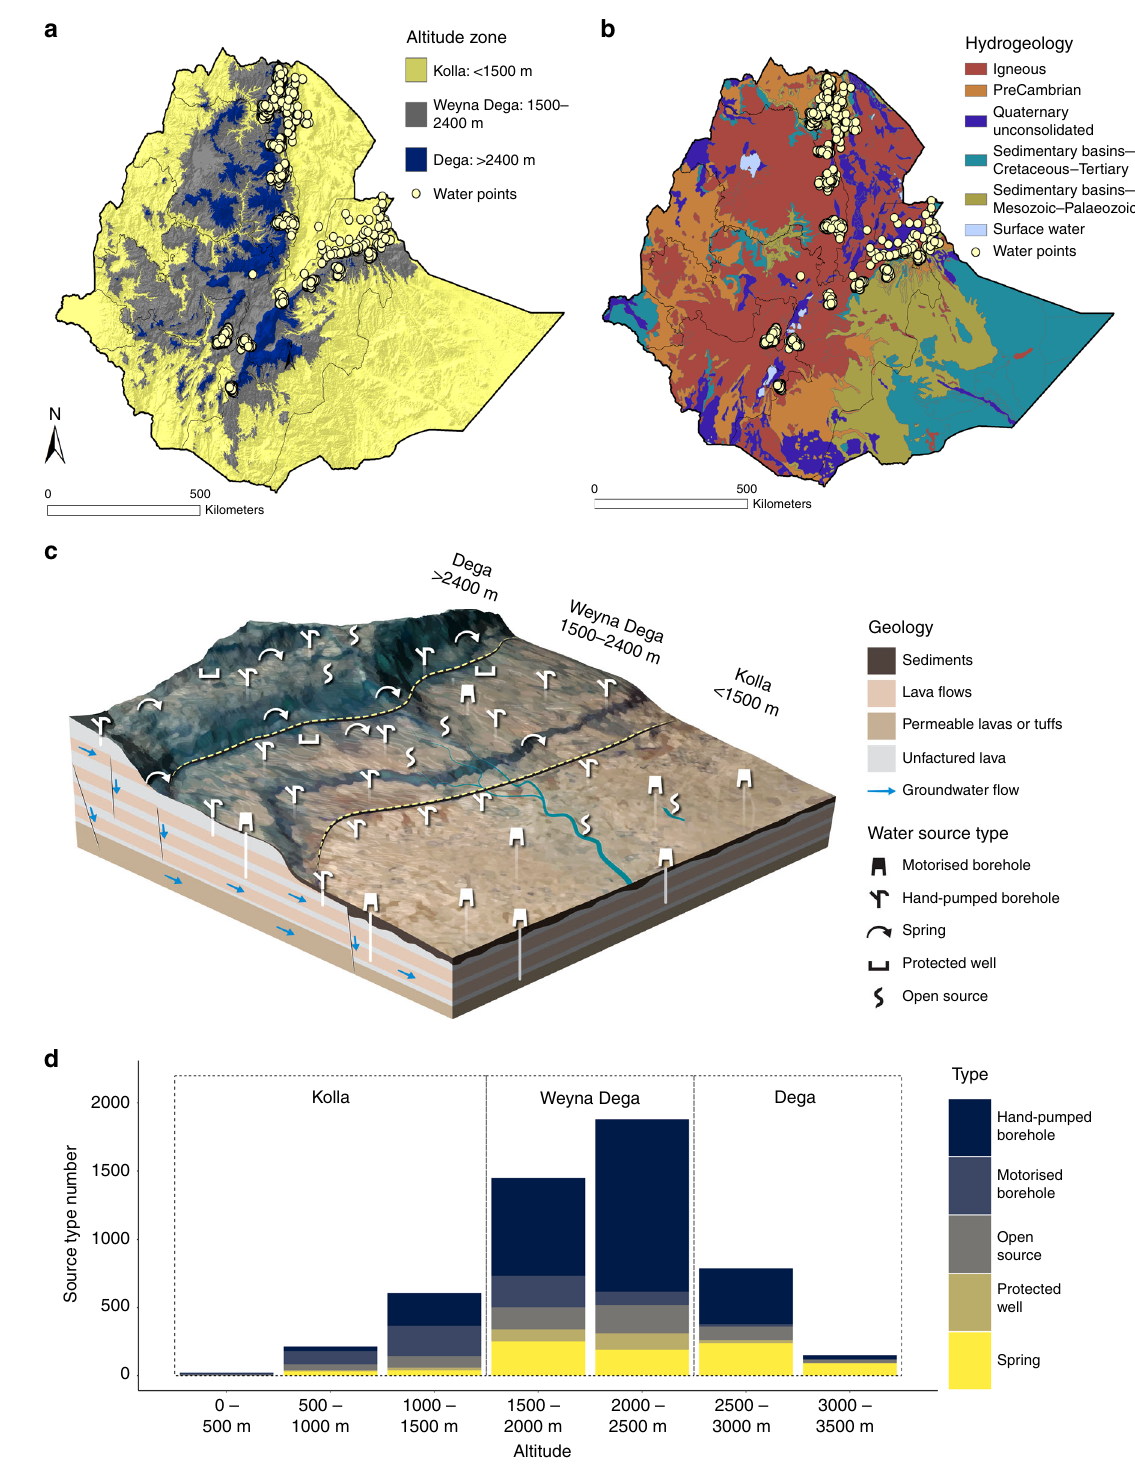
Fig. 1 Location and number of water sources, altitude zones and hydrogeology of the study area. a Altitude zones of Ethiopia and locations of water points monitored during the survey period. b Hydrogeology of Ethiopia 61 . c Basic conceptual model of hydrogeology and rural water supply provision in Ethiopia. d Number of each water source type with